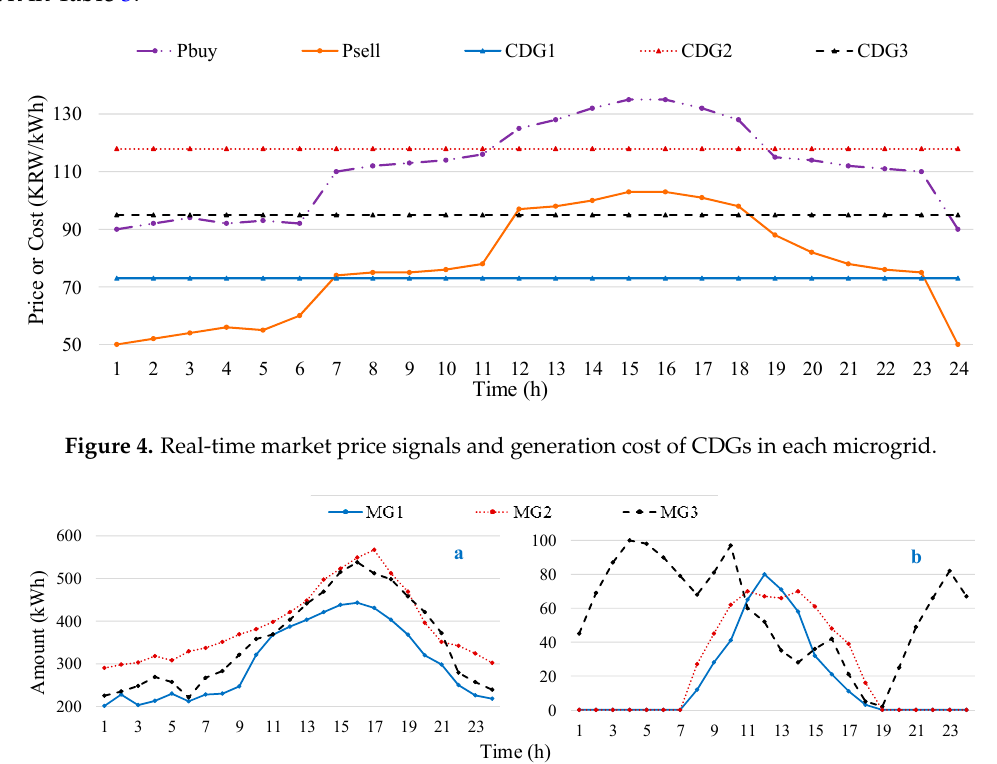
Table 4. Parameters related to controllable distributed generators (CDGs) and line capacities of the network.